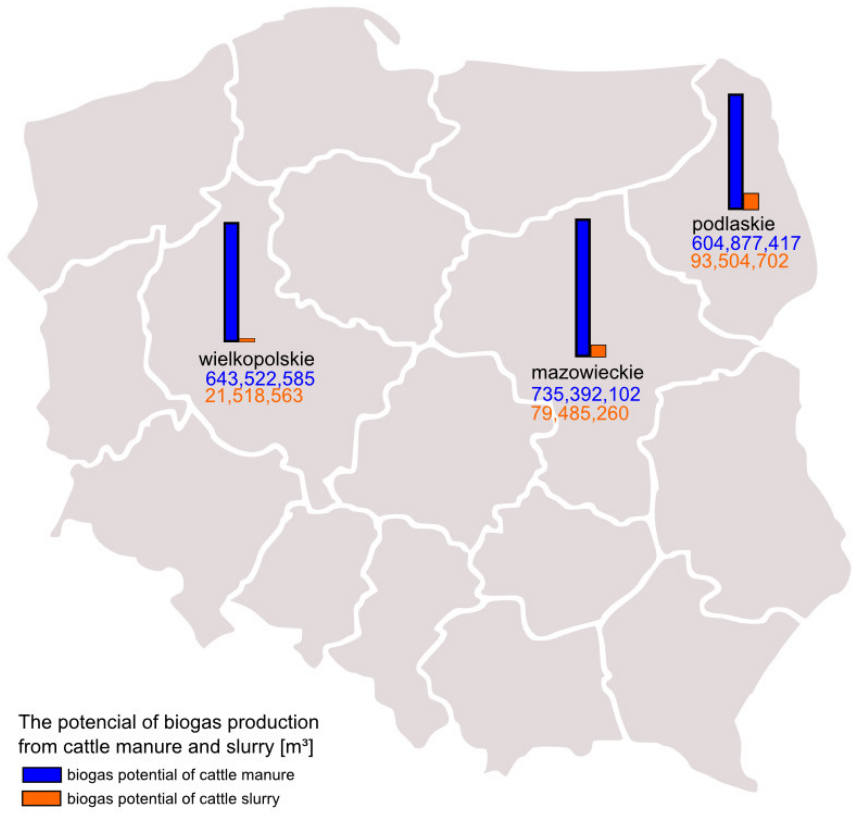
Figure 1. The potential of biogas production from cattle manure and slurry in the examined voivodeships in Poland based on data from 2018 [6].